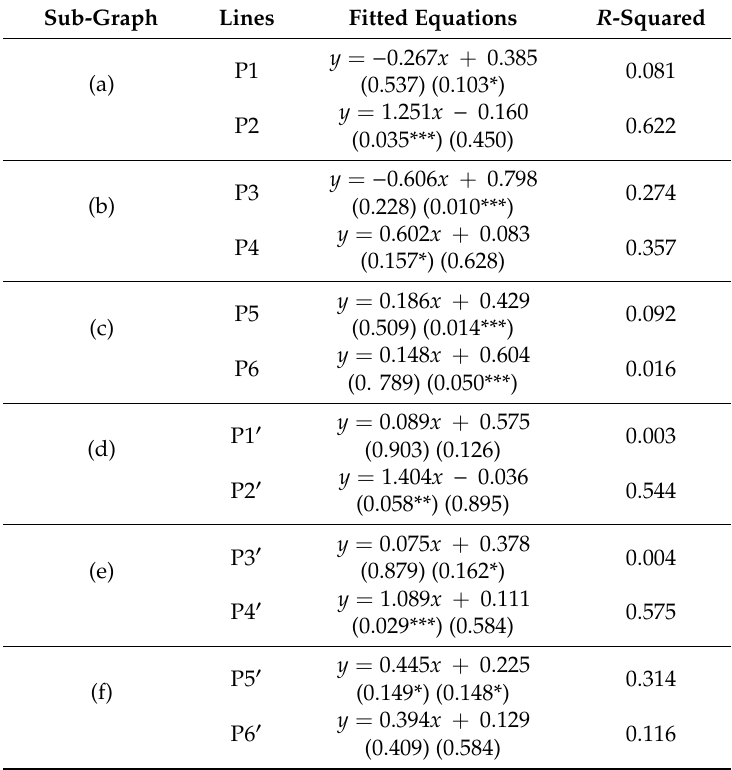
Table A4. Fitted equations and parameters for the curves in Figure